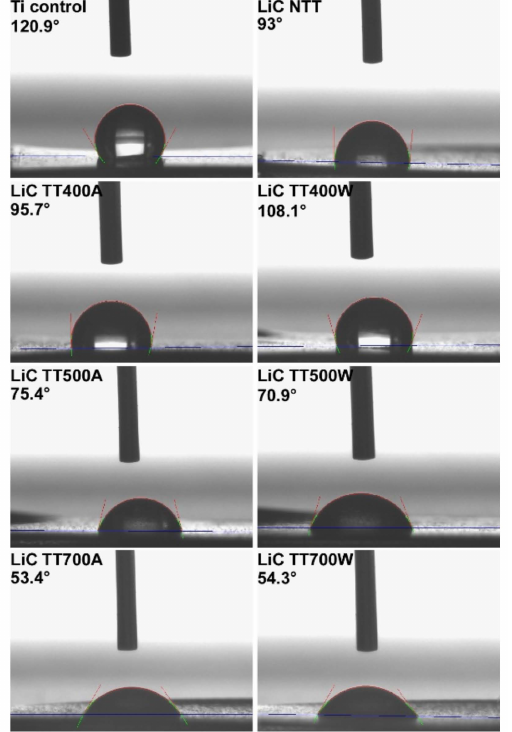
Figure 13. Representative images of the water droplets on control (Ti), NTT LiC and of those subjected to post-deposition thermal treatments (at different temperatures), in air and water-vapor ambient.